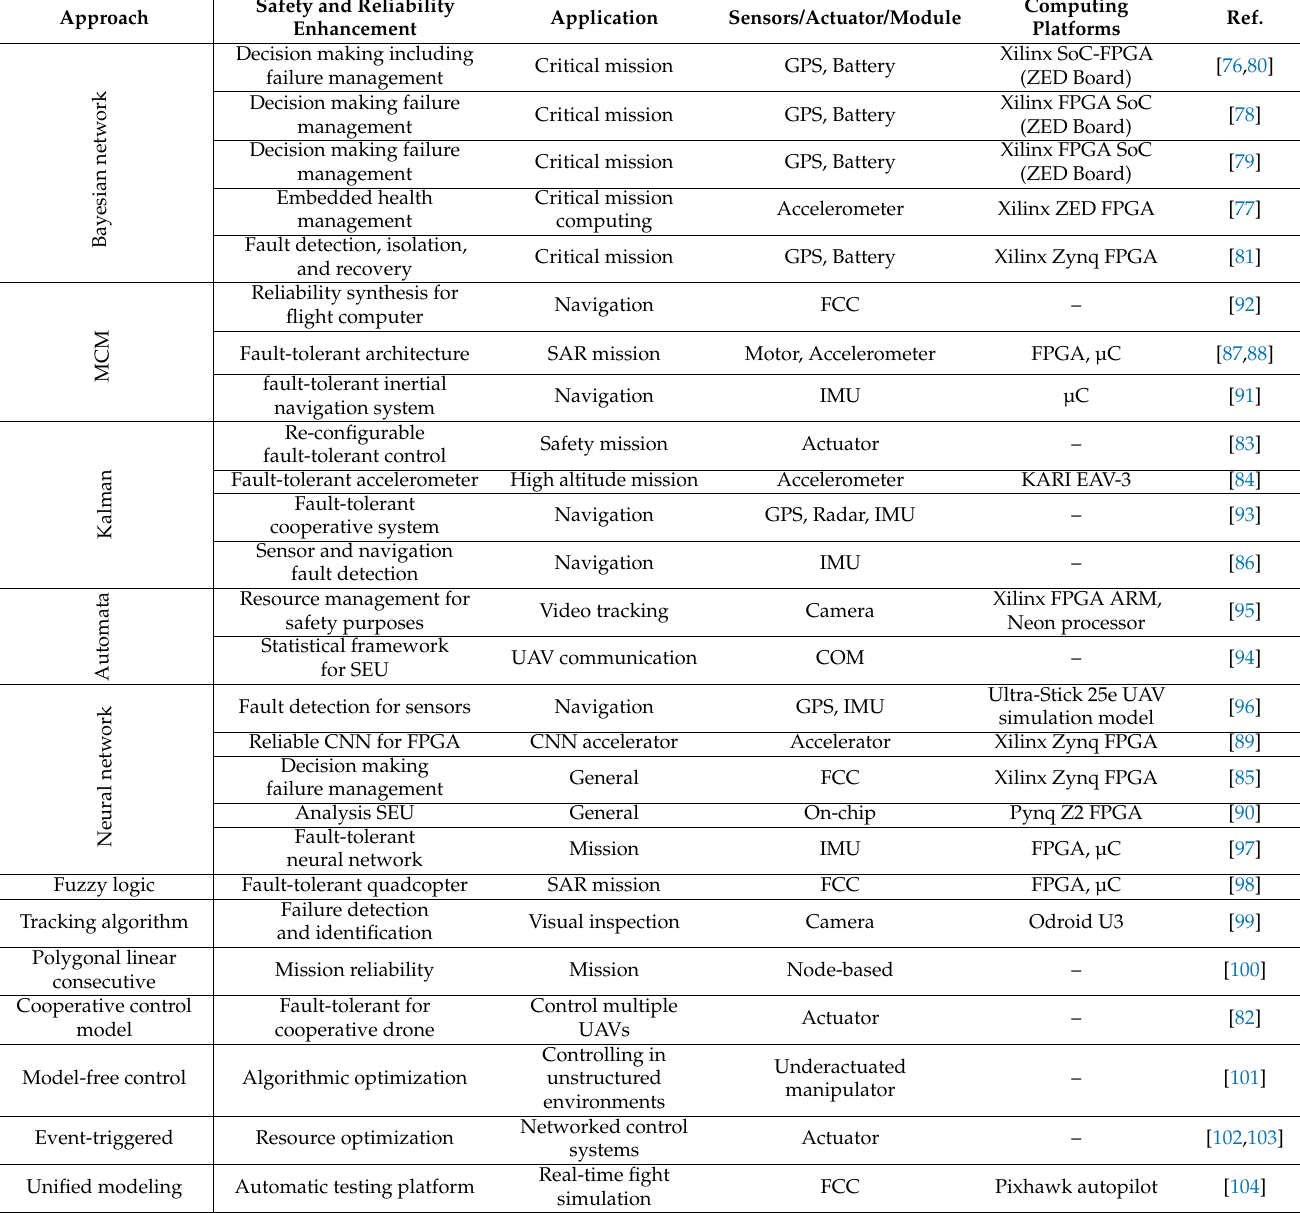
Table 7. Summary of reliability enhancement in UAV system